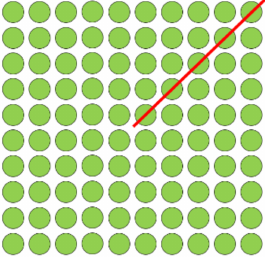
Figure 4. Symmetrical solder ball